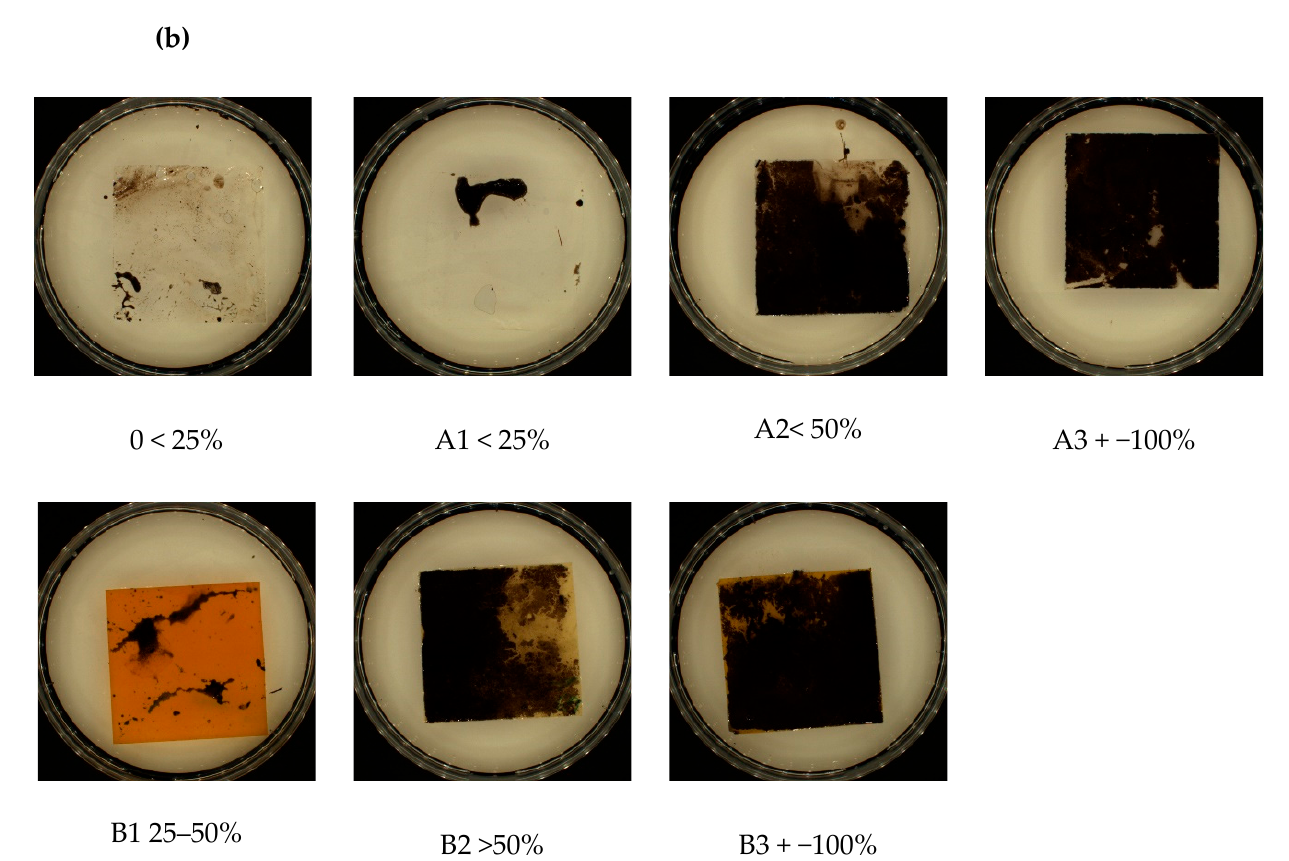
Figure 3. Visual analysis of samples after incubation: ( a ) with fungi and ( b ) with soil, with approximated overgrown area of samples (below abbreviations). Abbreviations: as in Table 2.